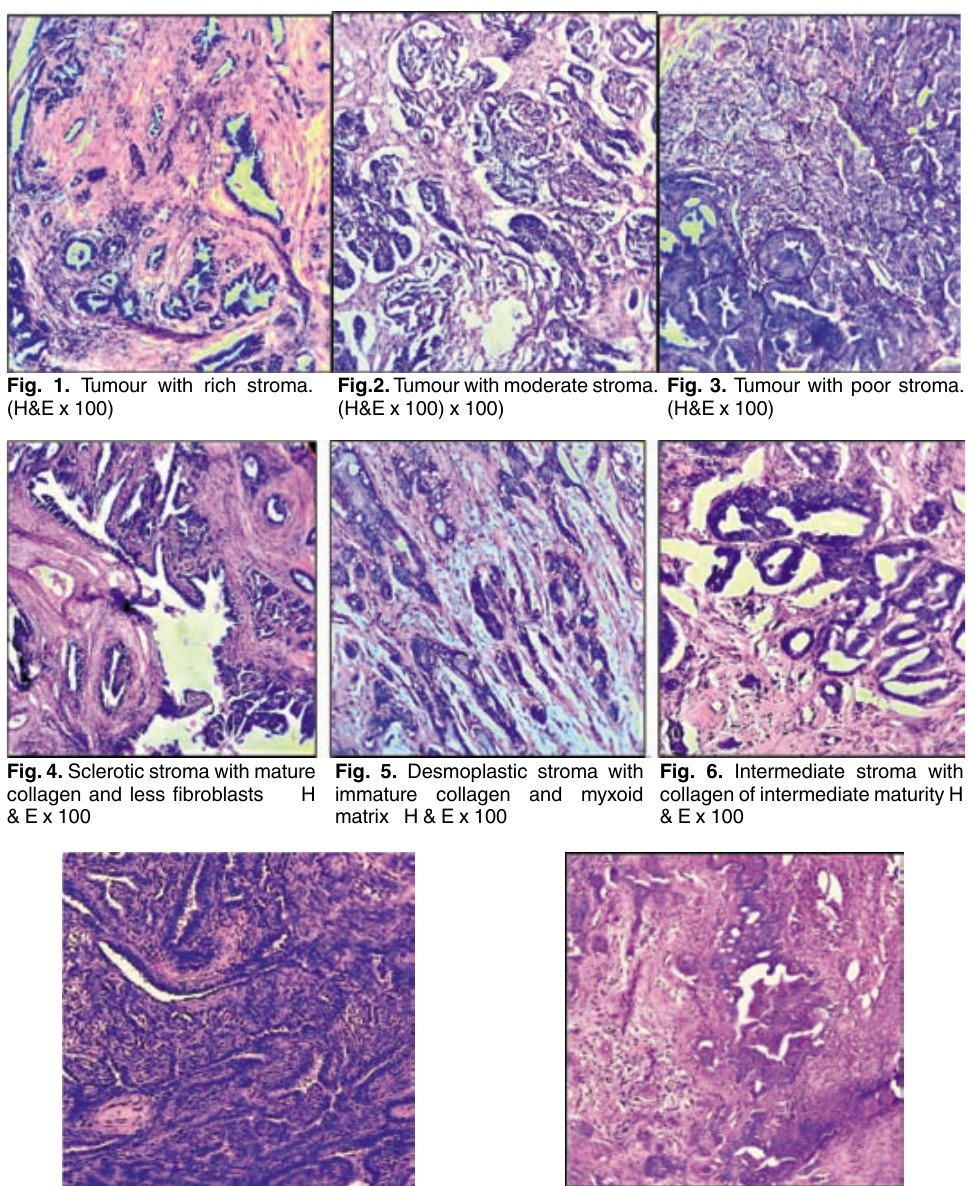
Fig.7. Inflammatory stroma H & E x 100 Fig.8. Mixed stroma H & E x